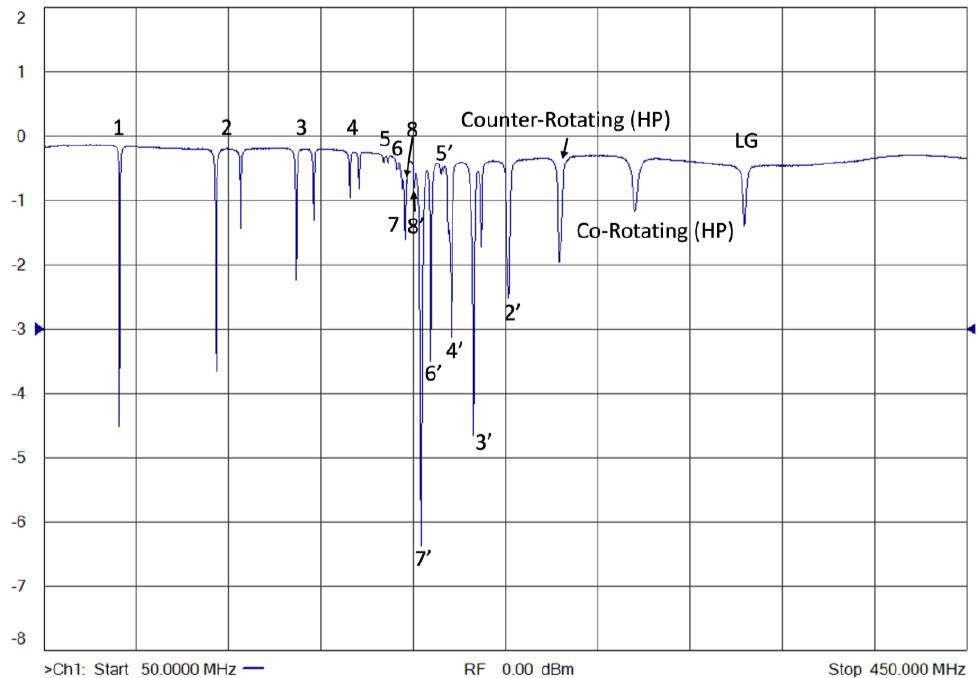
Figure 13. Measured S 11 full spectrum of the four-ring DT-RF coil prototype with both sodium and proton resonant structures connected, frequency sweep from 50 to 450 MHz. Numbers without apex refer to the LF resonant modes (1 to 8) with frequencies 81.8, 130.4, 162.1, 184.6, 197.7, 203.3, 205.1, 207.0 MHz. Numbers with apex refer to the HF resonant modes (8 ′ to 2 ′ ) with frequencies: 209.8, 213.6, 217.3, 222.0, 226.6, 237.9, 250.9 MHz. Counter-Rotating and co-rotating HP modes have fre-